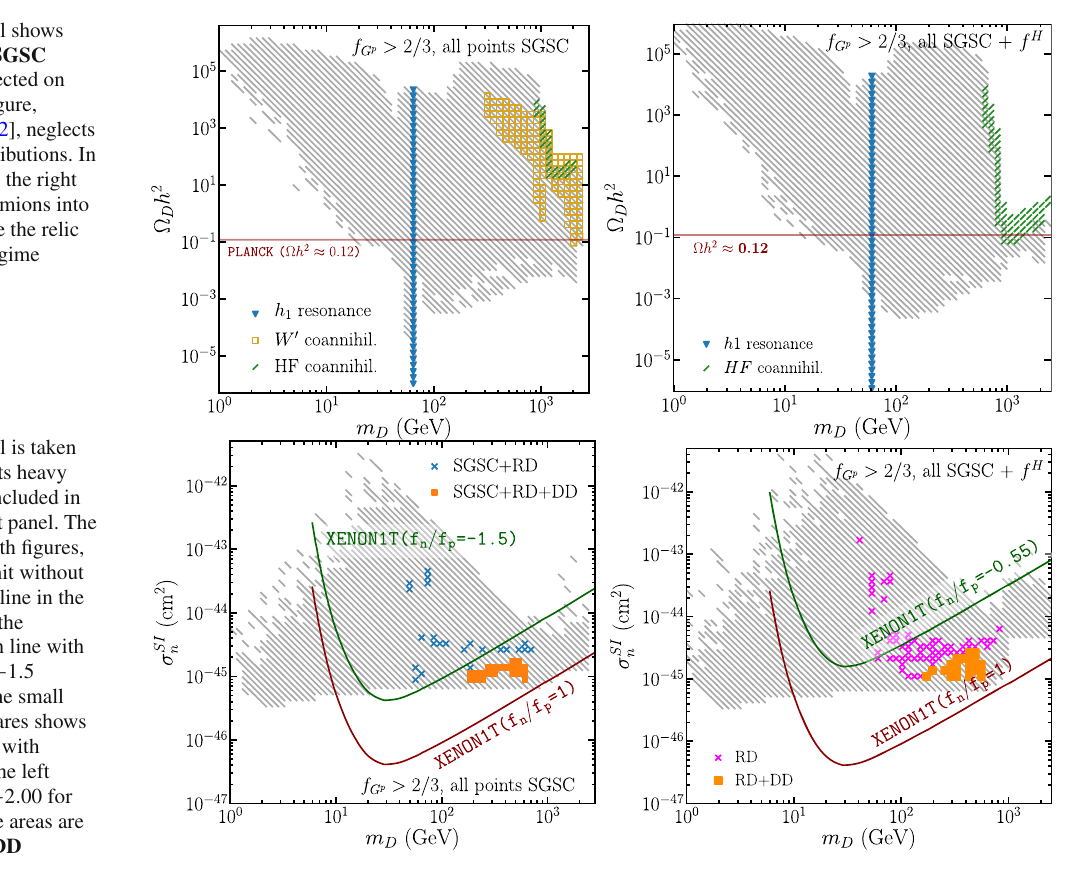
Fig. 5 The left panel shows Goldstone-like DM SGSC allowed regions projected on ( m D , (cid:13) D h 2 ). This figure, adopted from Ref. [32], neglects heavy fermions contributions. In contrast, the figure in the right panel takes heavy fermions into account which reduce the relic density in the TeV regime